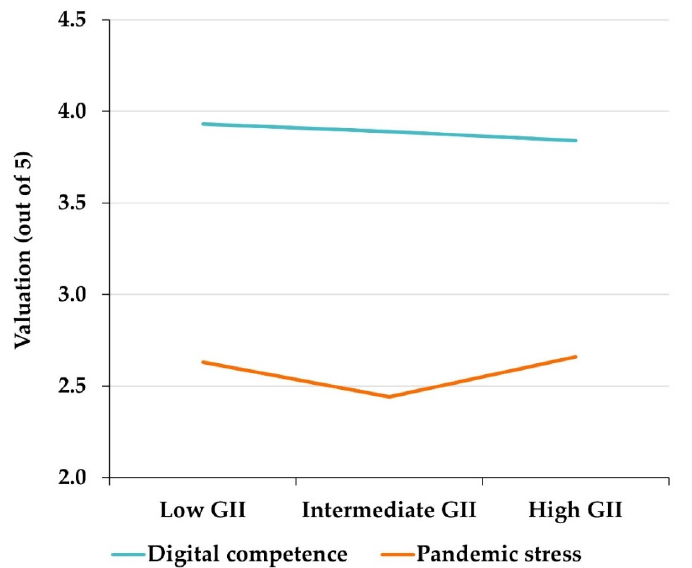
Figure 5. Variation in digital competence and pandemic stress from the use of DLEs, by country-of- origin GII.